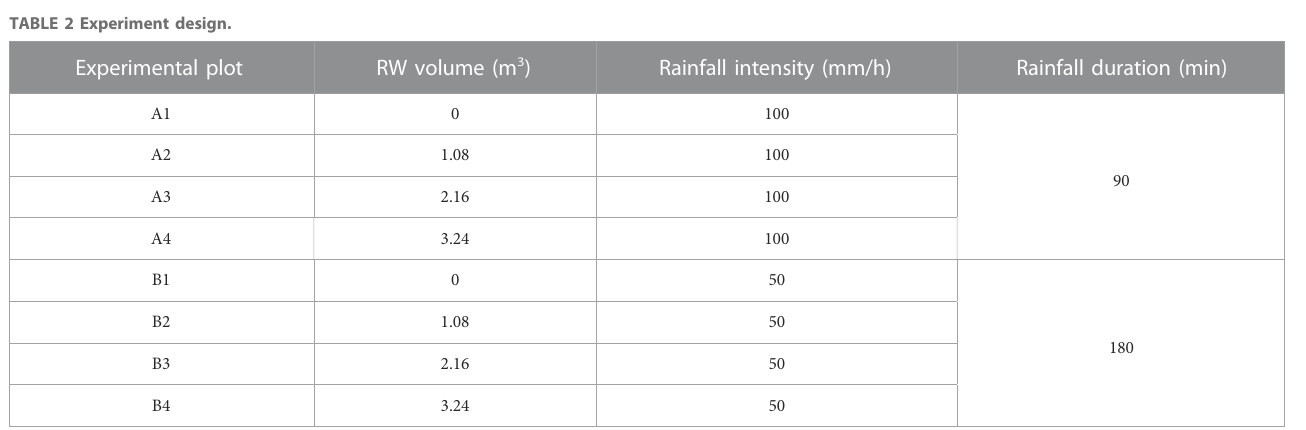
TABLE 2 Experiment design. Experimental